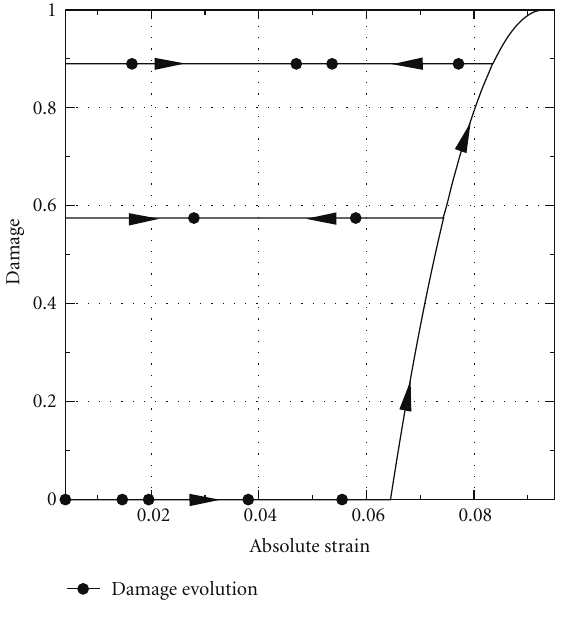
Figure 17: Finite element mesh used in the compression test